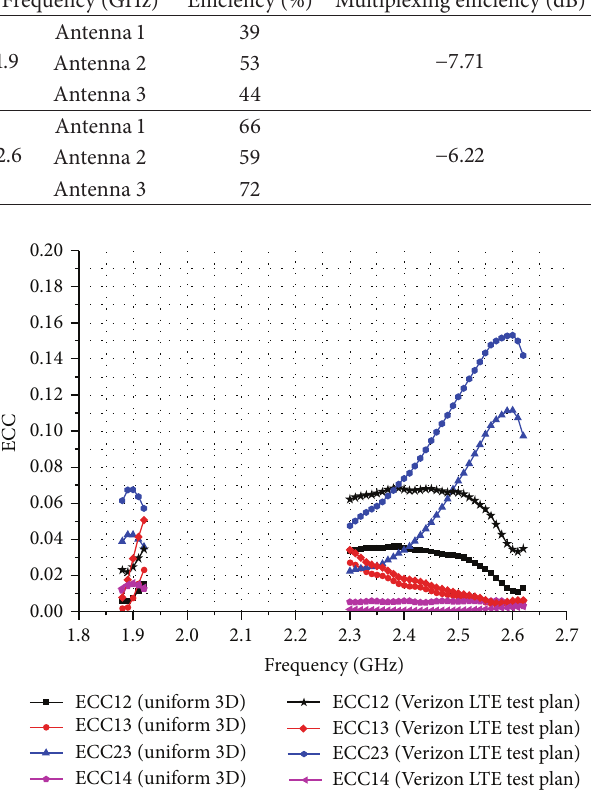
Figure 18: The ECC of antennas 1, 2, and